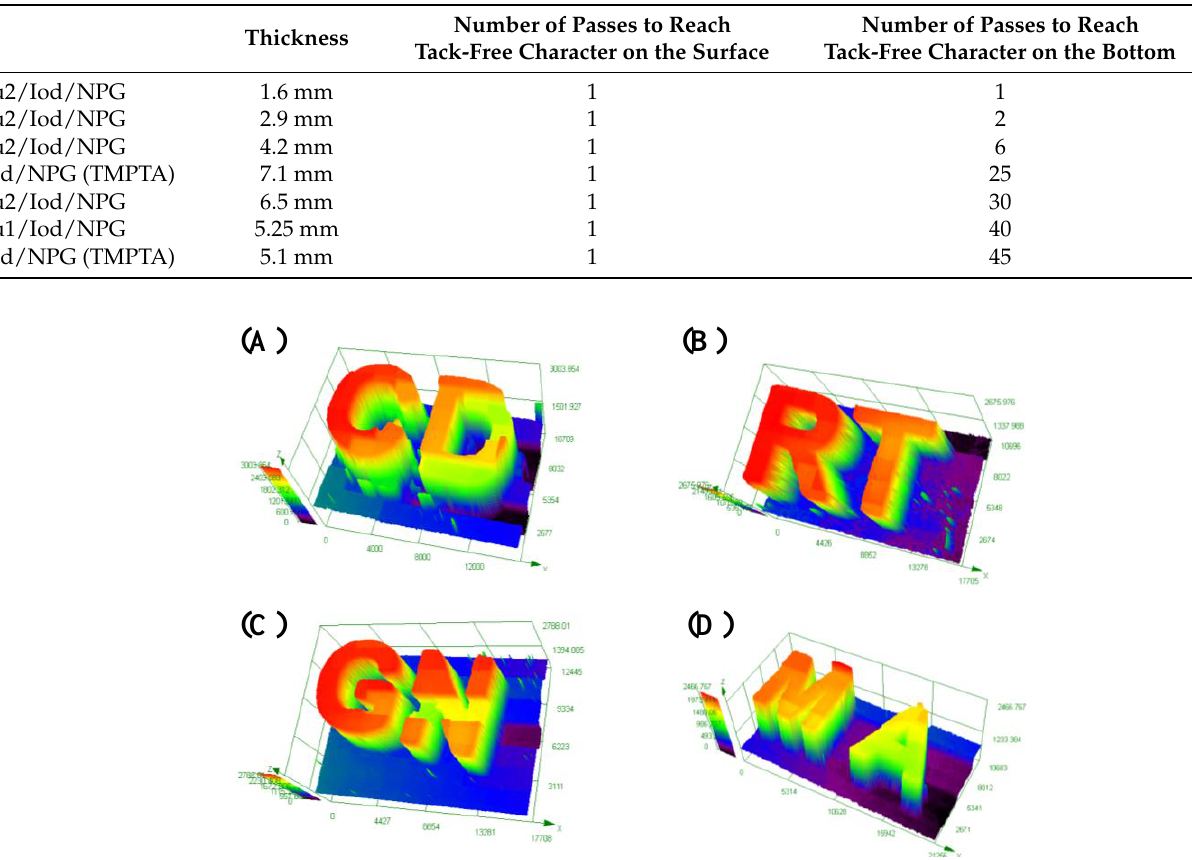
Figure 9. 3D patterns produced by free radical photopolymerization of acrylate functions (TA or TMPTA) using a laser diode at 405 nm and their characterization by numerical optical microscopy: ( A ) Cu2/Iod/TMA (0.057%/1%/0.46% w / w / w ) in TA, ( B ) Cu1/Iod/TMA